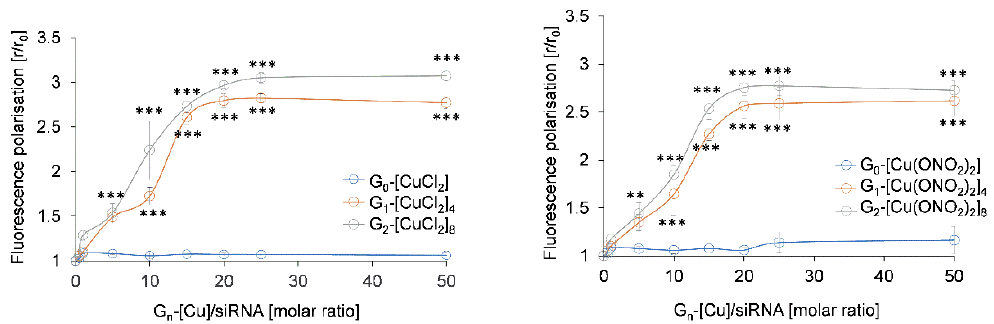
Figure 6. Changes in fluorescence polarisation of fluorescein-labelled Mcl-1 in the presence of increasing concentrations of different G n -[Cu] metallodendrimers. [siRNA] = 0.35 μM in Na - phosphate buffer 10 mM (pH 7.4). Results are represented as mean ± standard deviation (n = 3). Statistically significant differences compared to the control cells p ≤ 0 .05 (*); p ≤ 0 .01 (**); p ≤ 0 .001 (***).